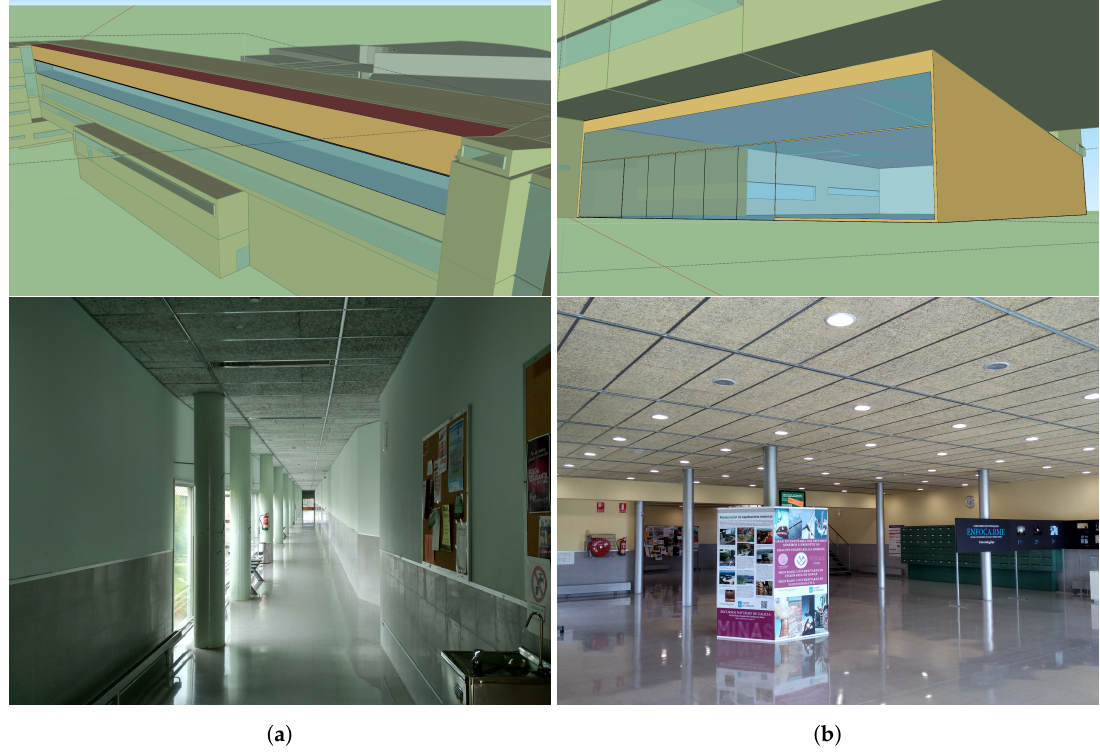
Figure 3. Spaces used in the experiments: ( a ) classroom corridor, rectangular lamps (Model 4); and ( b ) hall, circular lamps (Model